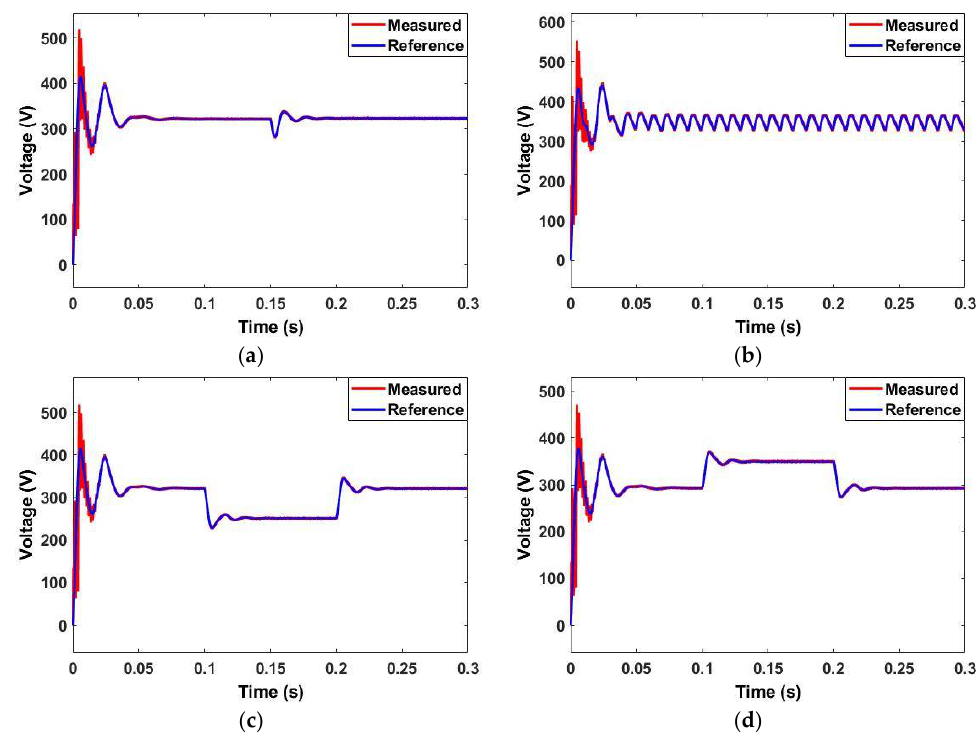
Figure 10. DC link voltage V dc using the PI controller: ( a ) under NGO with a step response at 0.15 s; ( b ) under AGO; ( c ) during voltage sag and ( d ) voltage swell in grid voltage